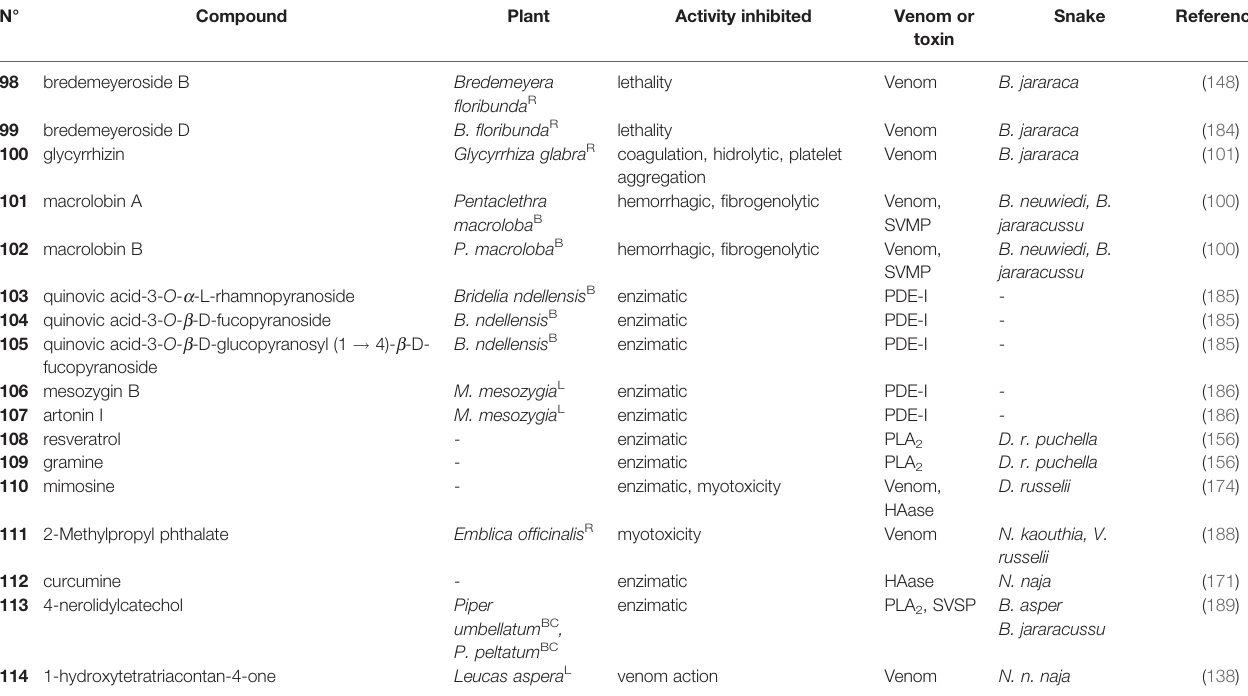
L, leaves; R, roots; B, bark; BC, branches. Hyaluronidase, HAase; Phosphodiesterase I, PDE-I; Phospholipase A 2 , PLA 2 ; Metalloproteinase, SVMP; Serine protease, SVSP.